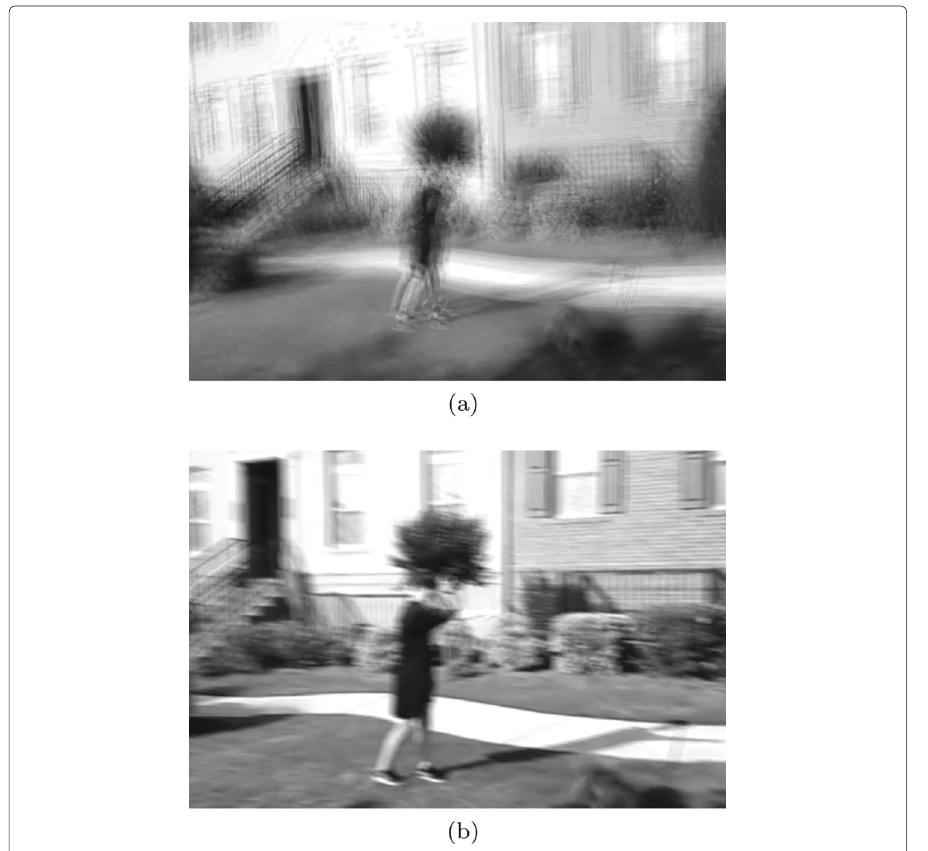
Fig. 3 The average gray levels for the first ten frames. a Original video. b Stabilized video